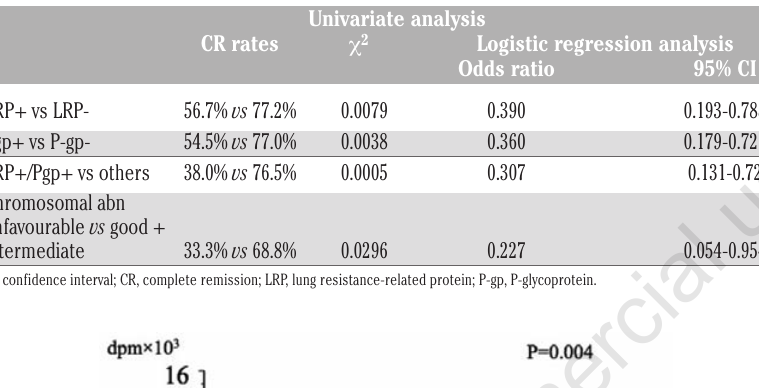
Table 2. Risk factors which affect inferior complete remission